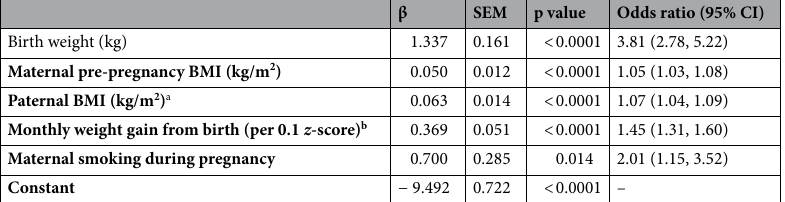
Table 2. Parameters for the final childhood obesity prediction model derived from the Growing Up in New Zealand subset. BMI body mass index, CI confidence interval, SEM standard error of the mean. a Collected during partner’s pregnancy. b Average monthly change in weight z -score from birth until the last recorded measurement between 6 and 12 months of age.